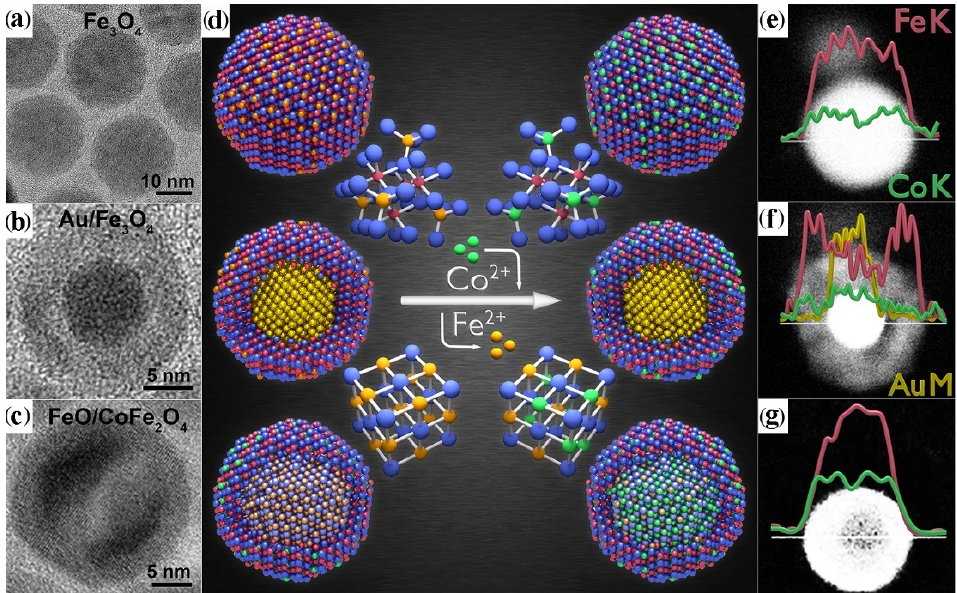
Figure 5. Gallery of representative core@shell CNHSs resulting from partial on-exchange reactions (cf. Scheme 2d) across preformed core@shell CNHS seeds: ( a – c ) TEM images of the starting substrates, namely homogeneous Fe 3 O 4 CNCs, Au@Fe 3 O 4 core@shell CNHSs, and Fe 1 − x O@CoFe 2 O 4 core@shell CNHSs, respectively; ( d ) Scheme of the cation-exchange process intervening in the nanocrystal seeds shown in panels ( a – c ) (blue balls represent oxygen atoms; red balls, Fe 3+ ; orange balls, Fe 2+ ; green balls, Co 2+ ; gold color, Au atoms). ( e – g ) High-angle annular dark-field STEM images of the nanostructures are shown in panels ( a – c ), respectively, after Fe 2+ to Co 2+ cation exchange. The distributions for Fe (red) and Co (green), and Au (golden) across the nanocrystals, shown by the EDX line scans (obtained for transitions from the K or M shell, respectively), reveal Co doping after the cation-exchange reaction (reproduced with permission from Ref. [195], Copyright 2013, American Chemical Society).